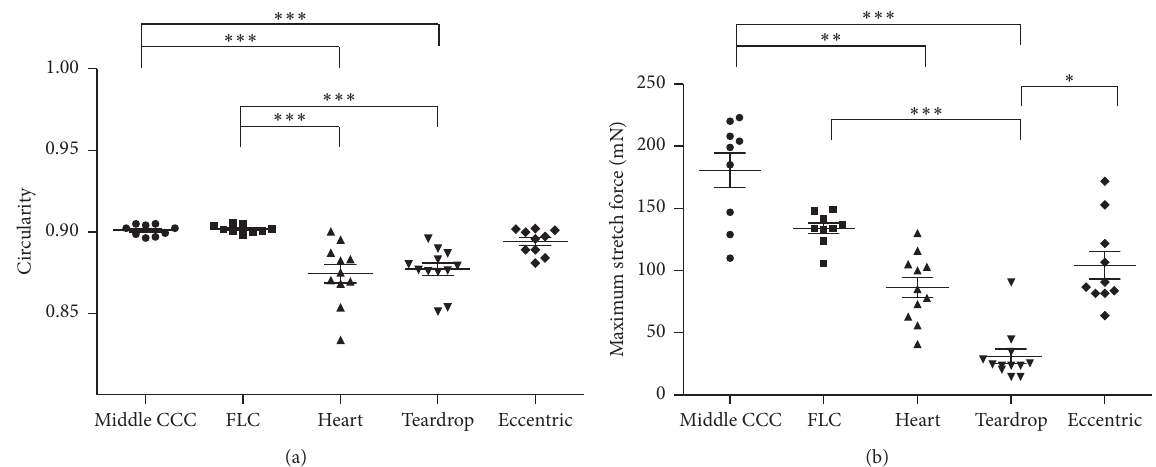
Figure 5: Comparison of circularity (a) and stretch force (b) among the CCC subgroups and the FLC group. The heart- and teardrop-shaped CCC subgroups showed significantly lower circularity than the middle CCC subgroup and FLC group. The maximum stretch force in the teardrop-shaped CCC subgroup was significantly lower than those in the middle CCC subgroup, FLC group, and eccentric CCC subgroup. The maximum stretch force in the heart-shaped CCC subgroup was significant lower than that in the middle CCC subgroup. ∗ 𝑝 < 0.05 , ∗∗ 𝑝 < 0.001 , and ∗∗∗ 𝑝 < 0.0001 .